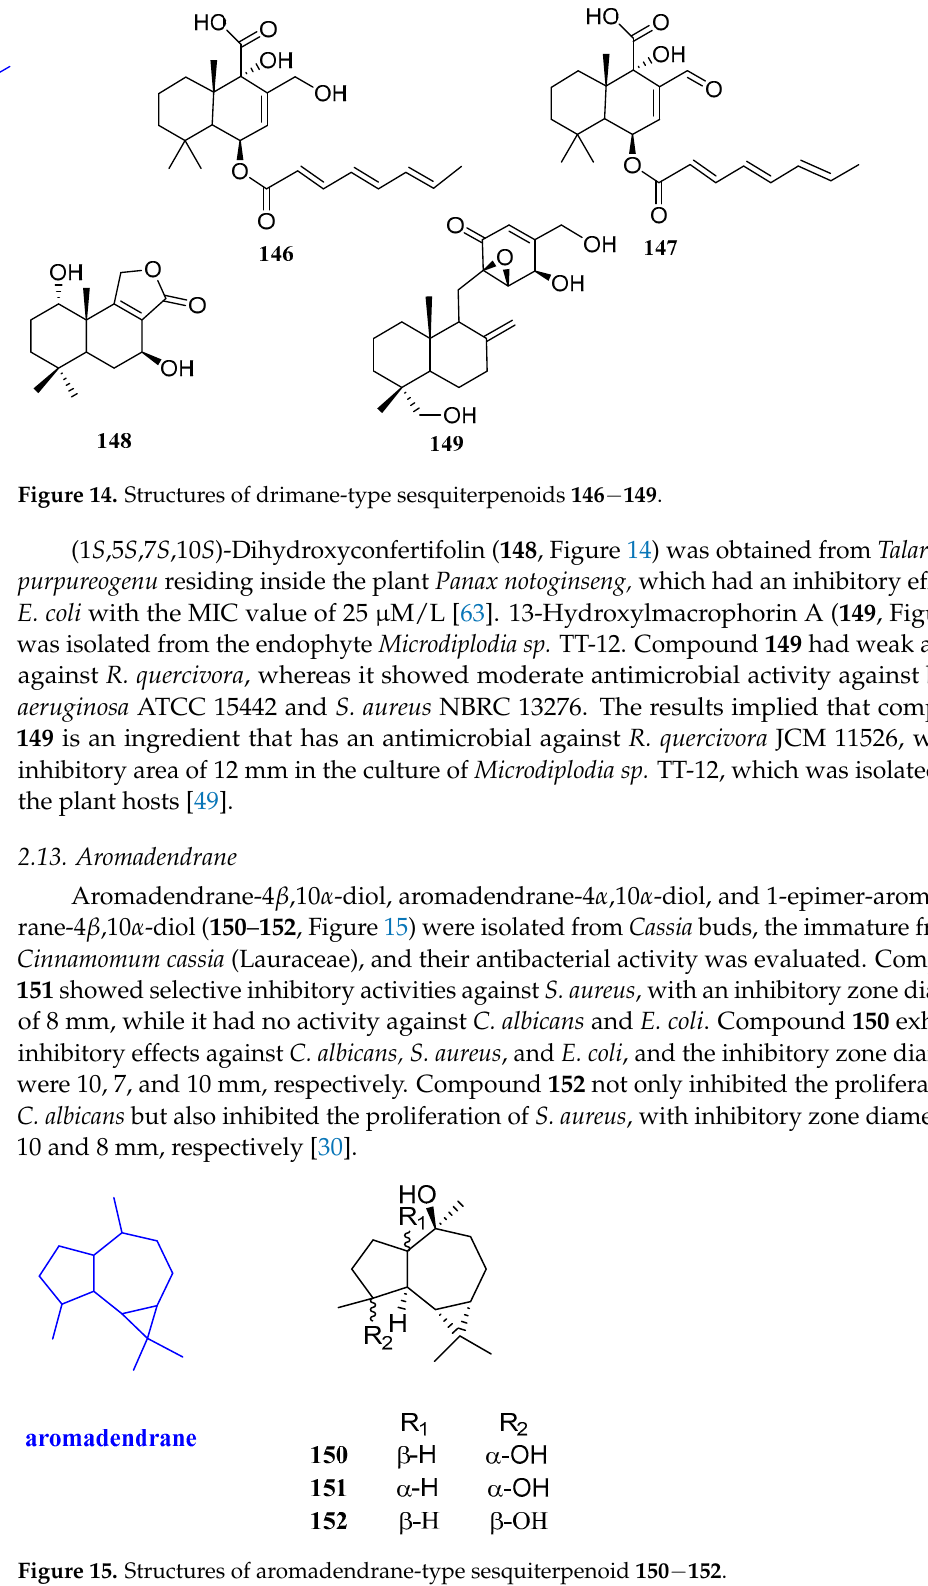
Figure 16. Structures of cuparane - type sesquiterpenoids 153 ‒ 155 . Debromolaurinterol and α -bromocuparane ( 154 and 155 , Figure 16) was isolated from Bornean Laurencia snapeyi . It was found that compounds 154 and 155 had good anti- bacterial activity against S. typhi , with a MIC/MBC ratio of 2.79 and 2.72, indicating a bac- tericidal antibiosis [64]. 2.15. Daucanes Jaeschkeanadiol p -hydroxybenzoate (ferutinin), jaeschkeanadiol benzoate (teferidin), and jaeschkeanadiol vanillate (teferin) ( 156 ‒ 158 , Figure 17) were obtained from the root of Ferula hermonis . Compounds 156 ‒ 158 possessed antibacterial effects on MRSA, B. sub- tilis, Mycobacterium tuberculosis ( M. tuberculosis ) , and M. bovis , with MIC values ranging from 0.39 to 8 µg/mL. In this study, positive controls including tetracycline, isoniazid, ciprofloxacin, and chloramphenicol were used; however, no comparison was addressed between the potency of antibiotics and those of compounds 156 ‒ 158 [65].